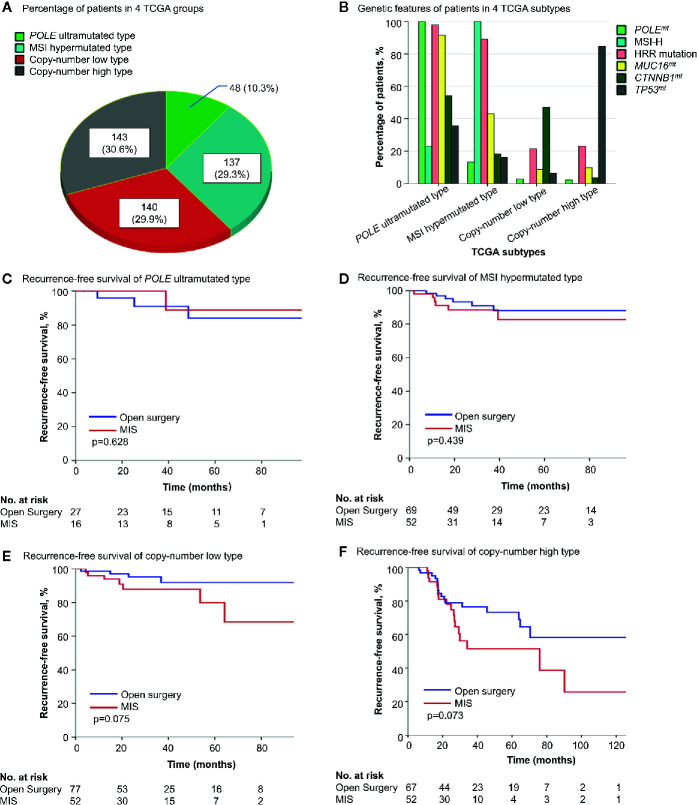
The survival influence of surgical approach in different TCGA molecular subgroups. (A) The distribution of 4 TCGA molecular subtypes in the cohort. (B) Genetic alterations in each molecular subtype. (C–F) Kaplan-Meier survival curves of patients with different molecular features by surgical approach. TCGA, the Cancer Genome Atlas; POLEmt, POLE mutation; MSI-H, microsatellite-instability high; HRR, homologous recombination repair; MUC16mt, MUC16 mutation; CTNNB1mt, CTNNB1 mutation; CTNNB1wt, CTNNB1 wild type; TP53mt, TP53 mutation; TP53wt, TP53 wild type; MIS, minimally invasive surgery.